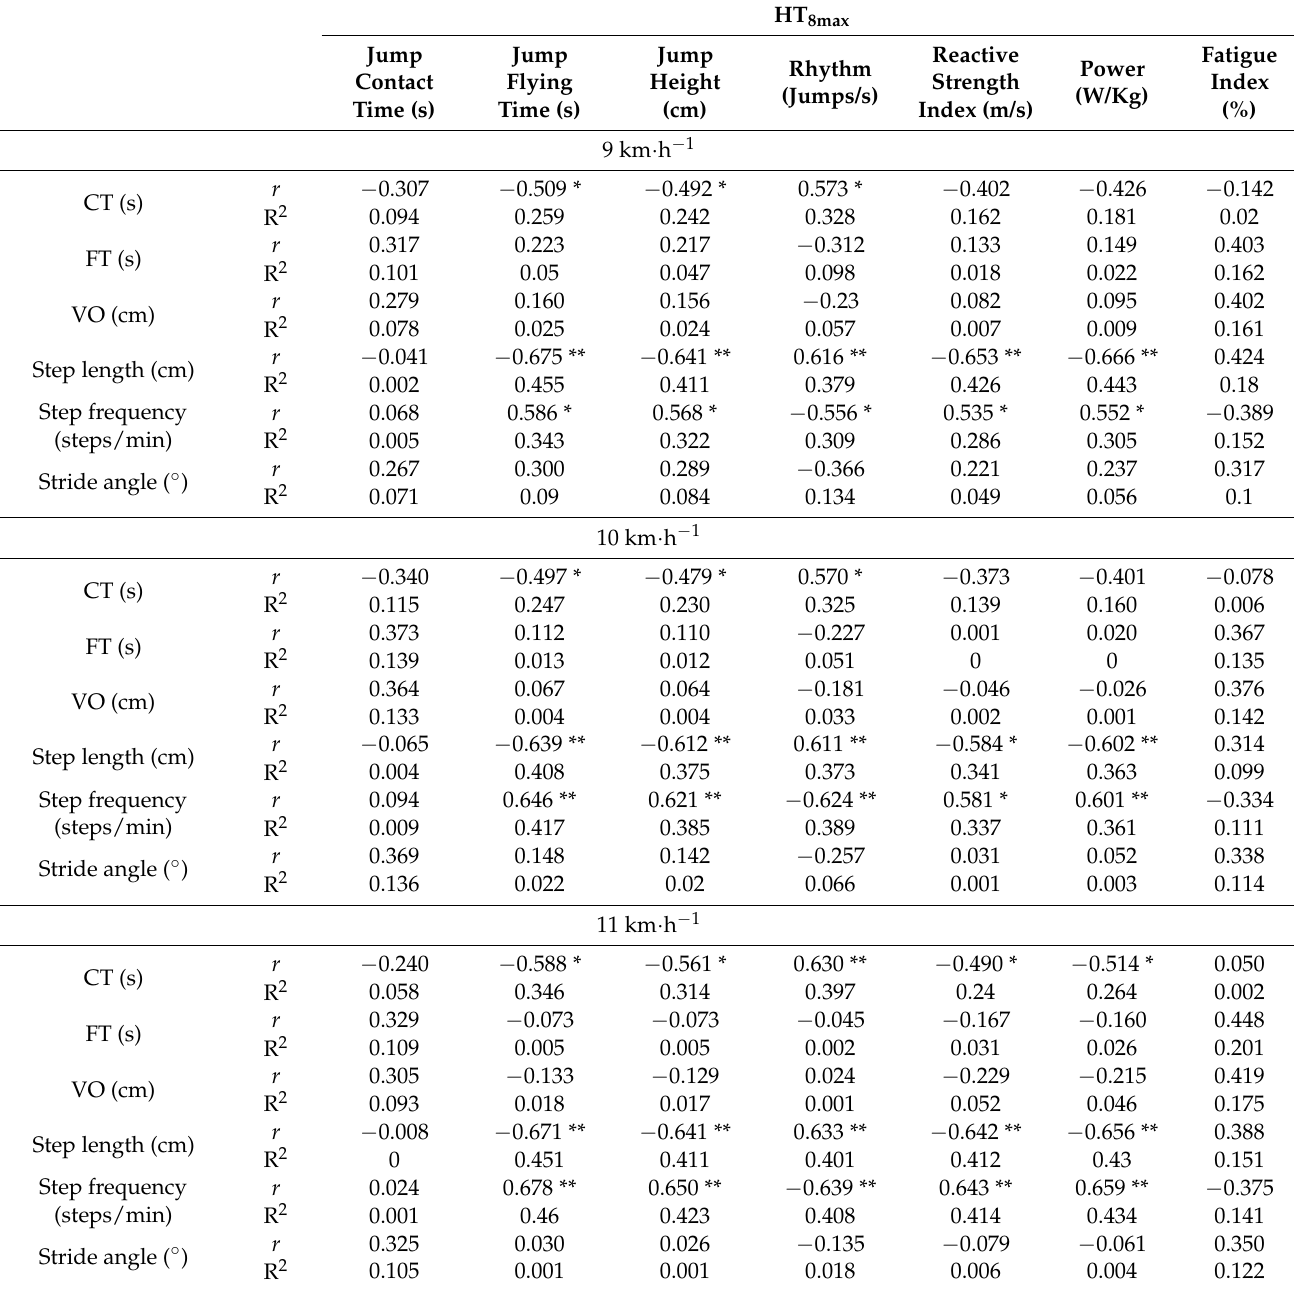
Table 3. Correlation coefficients and estimation of effect size between spatiotemporal variables and HT 8max at 9 km · h − 1 , 10 km · h − 1 , and 11 km · h − 1